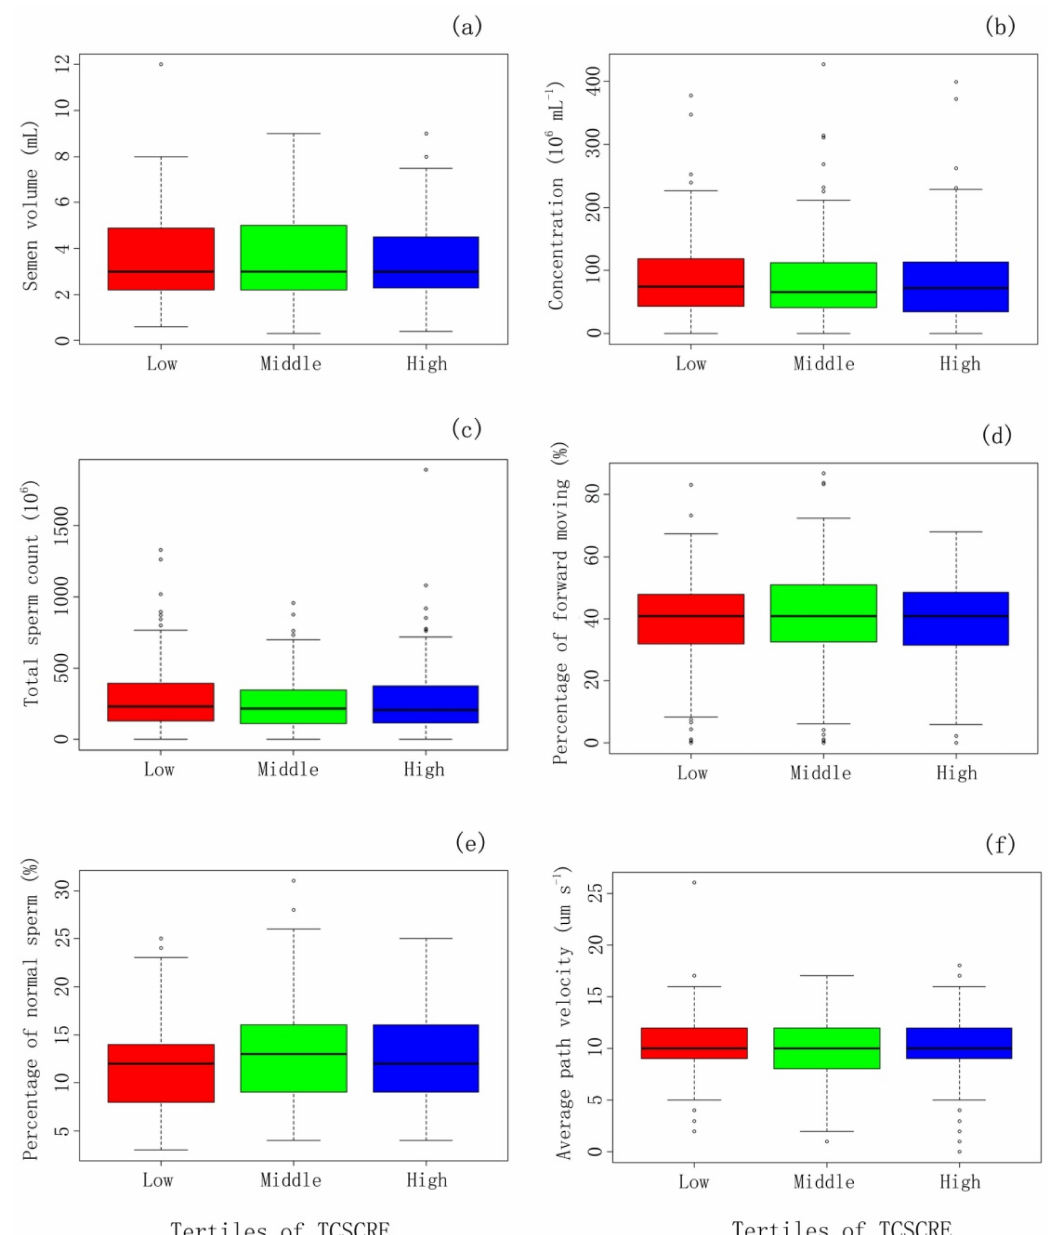
Figure 2. Comparison of semen quality parameters between tertiles of urinary TCS concentration among Chinese men (471) recruited during November 2013–March 2014. The x -axis refers to tertiles of urinary TCS level corrected by creatinine concentration (TCSCRE): low tertile (<0.66 ng ¨ mg ´ 1 ), middle tertile (0.66–2.33 ng ¨ mg ´ 1 ) and high tertile ( ě 2.33 ng ¨ mg ´ 1 ); The y -axis refers to sperm quality parameters, including semen volume ( a ); sperm concentration ( b ); total sperm count ( c ); percentage of forward moving ( d ); percentage of normal sperm ( e ) and average path velocity ( f ). The five lines extending vertically along Y-axis from top to bottom are respectively defined to be: Q3 (75%) + 1.5 ˆ inter quartile range (IQR), Q3, median, Q2 (25%), Q2 ´ 1.5 ˆ